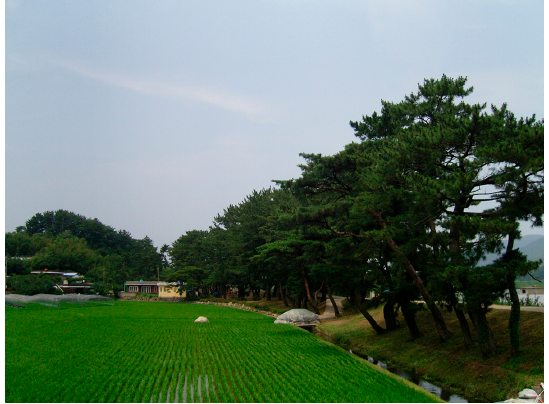
Figure 2. A community forest in Gwangyang, South Korea. The forest is located near croplands and residential area to prevent strong wind and flooding.